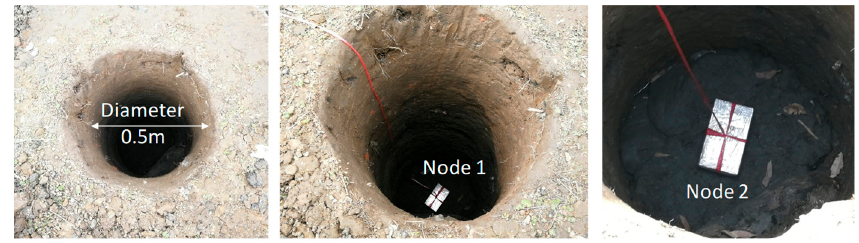
Figure 6. Steps for the onsite experiment.